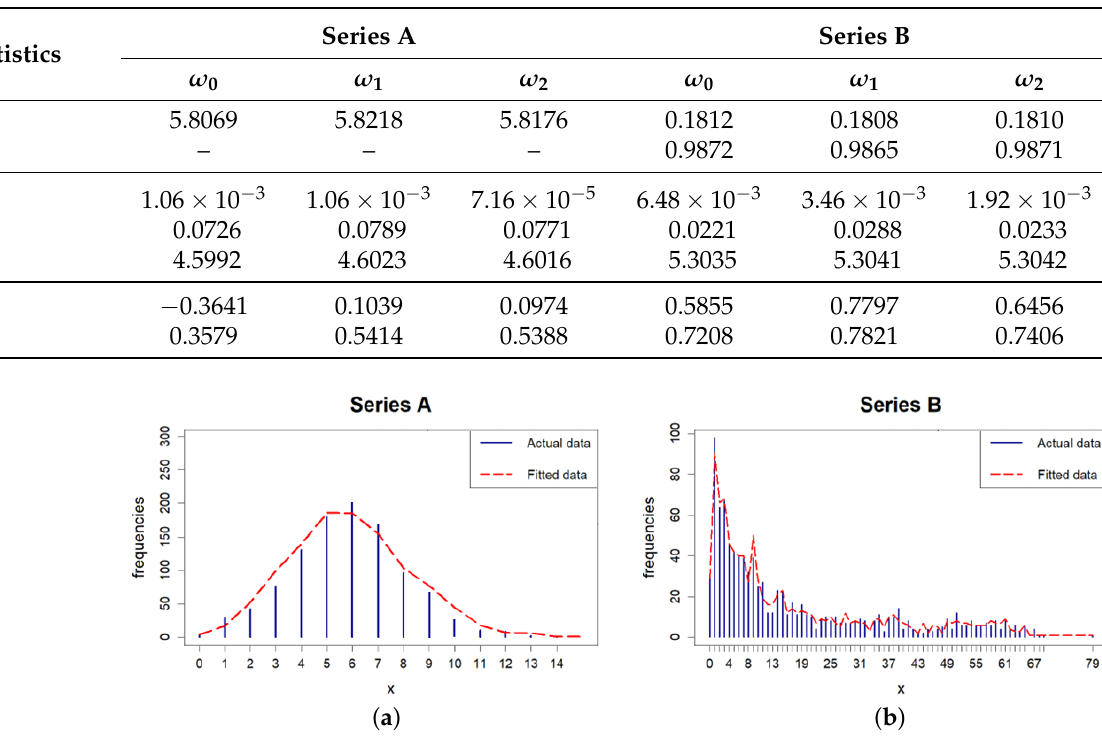
Table 5. Estimated values of parameters, along with error and predictive statistics of the actual data.